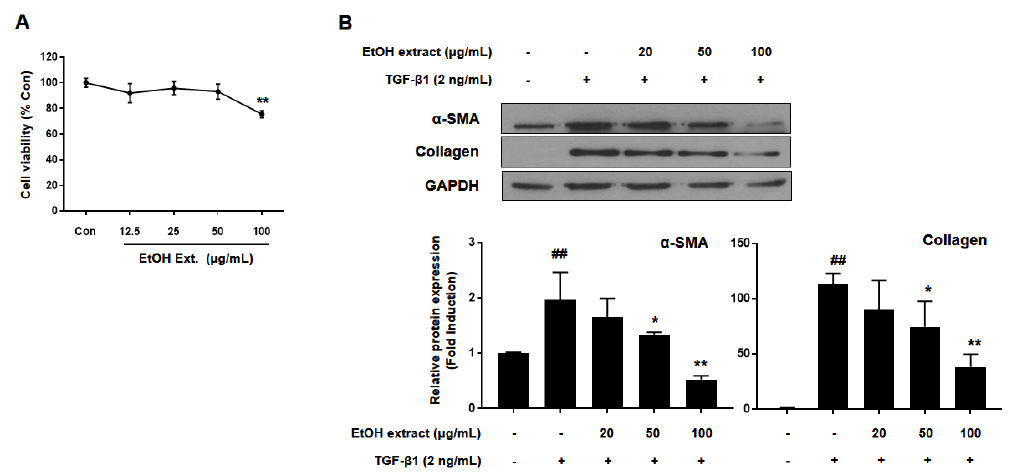
Figure 1. EtOH extract of R. palmatum inhibited the activation of LX-2 cells. ( A ) Cytotoxicity of EtOH extract of R. palmatum in LX-2 cells was measured by WST-1 assay. LX-2 cells were treated with EtOH extract of R. palmatum for 48 h after activation by TGF- β 1 for 48 h. ( B ) The protein expression levels of α -smooth muscle actin ( α –SMA) and collagen were analyzed by western blotting assay and quantified by Image J. Glyceraldehyde 3-phosphate dehydrogenase (GAPDH) was used as a loading control. Each experiment was repeated three times, and the values represent mean ± SD. ## p < 0.01 compared with the control, ** p < 0.01, * p < 0.05 compared with TGF- β 1-treated cells.